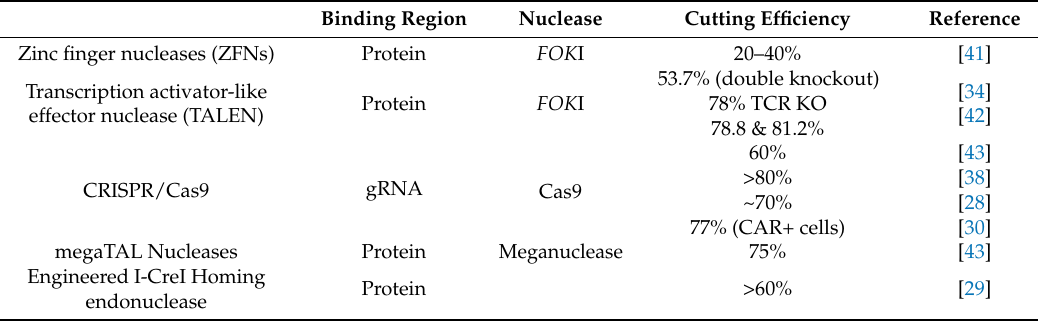
Table 1. Summary table of different gene editing techniques used to disrupt T cell αβ receptor (TCR αβ )